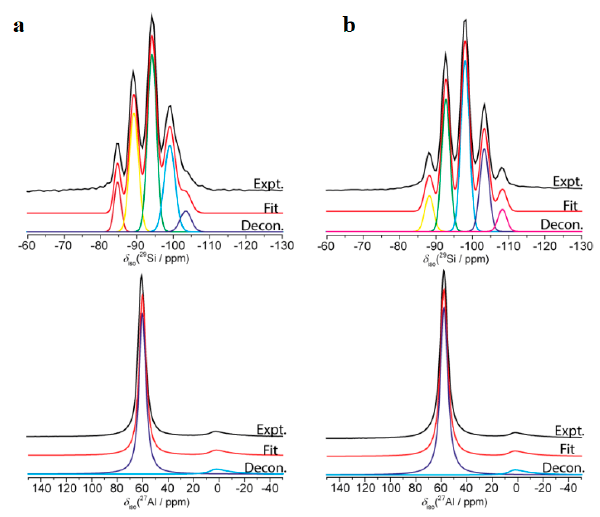
Figure 12. 29 Si ( top ) and 27 Al ( bottom ) MAS NMR data of: ( a ) NaY-MKSE and ( b ) NaY-SE.